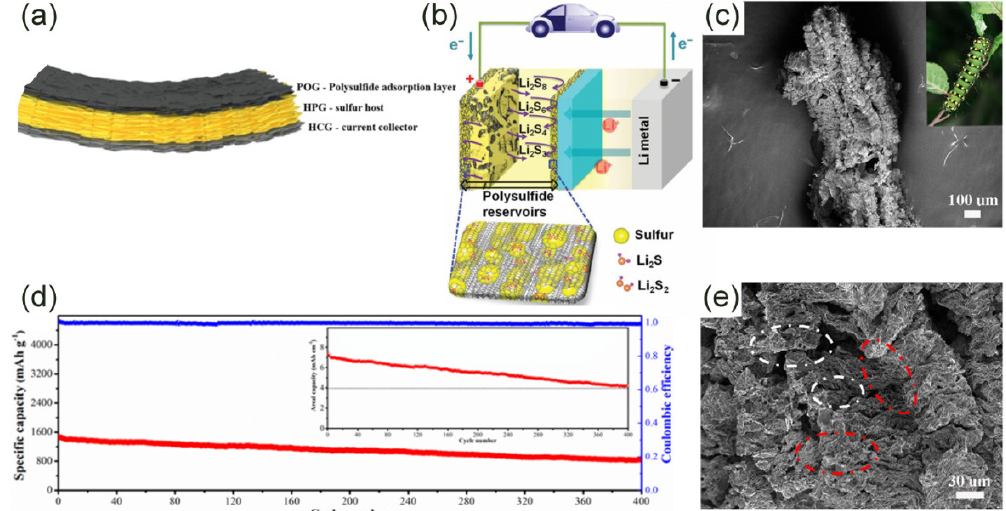
Figure 2. ( a ) Schematic diagram of all-graphene sandwich structure [48]. Copyright 2016, American Chemical Society. ( b ) Electrode configuration diagram: LiPSs are confined between graphene and diaphragm [45]. Copyright 2014, Springer Nature. ( c ) SEM image of caterpillar-like graphene [49]. Copyright 2017, Elsevier. ( d ) The long cycle test and the corresponding area capacity of the sulfur cathode at 0.34 A·g −1 [48]. Copyright 2016, American Chemical Society. ( e ) Layered (red circles) porous (white circles) structure shown by SEM image [49]. Copyright 2017, Elsevier.